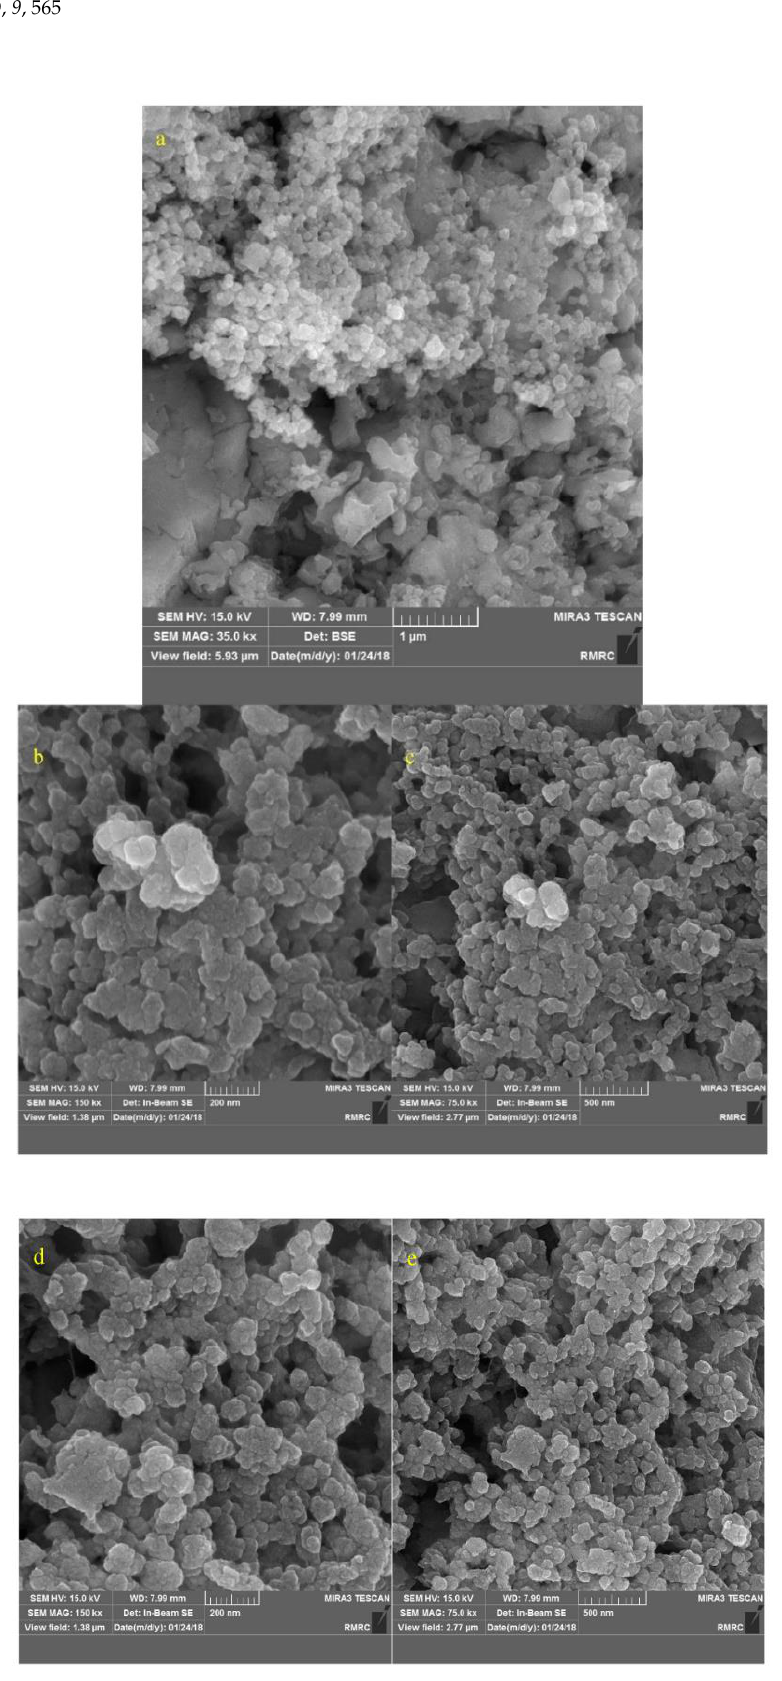
Figure 4. FE-SEM images of Pd/coral reef nanocomposite ( a – c ) and recycled Pd/coral reef nanocomposite ( d , e ).